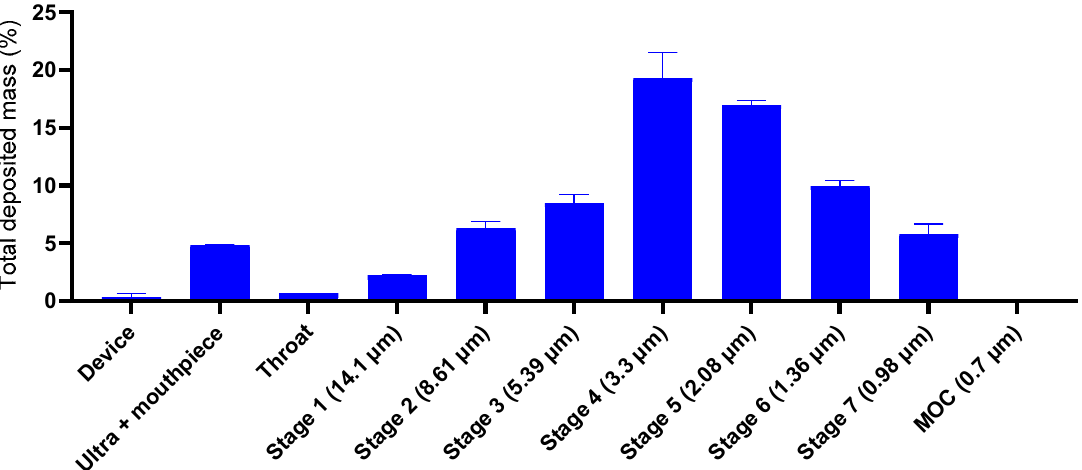
Figure 9. Quantification of the deposited ATRA-PLGA NPs. Mass distribution of nebulized nanoparticles using cascade impactor at 15 LPM (W7, Westech, UK). The mass of drug substance collected on each of the components was eluted with 5 mL of methanol and quantified using a UV-Vis spectrophotometer at 348 nm. Results are shown as the % total drug deposited on all stages of the impactor including the throat. The data are represented as nominal dose mass percentage. Data are shown as mean ± SD (n = 3).